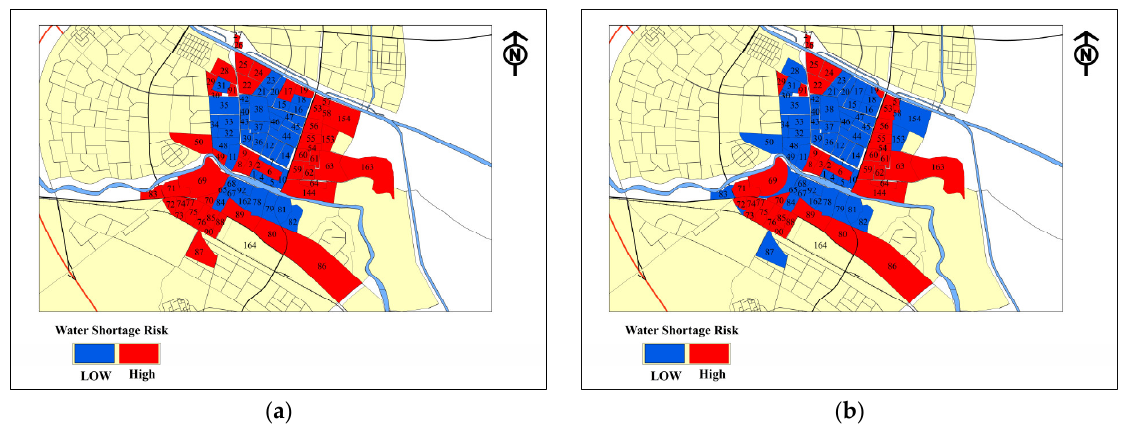
Figure 7. Map ( a ) was created by the direct representative method in GIS using the prediction results of RF, whereas map ( b ) was produced by the WLC technique of GIS, using the criteria weights extracted by RF algorithm.